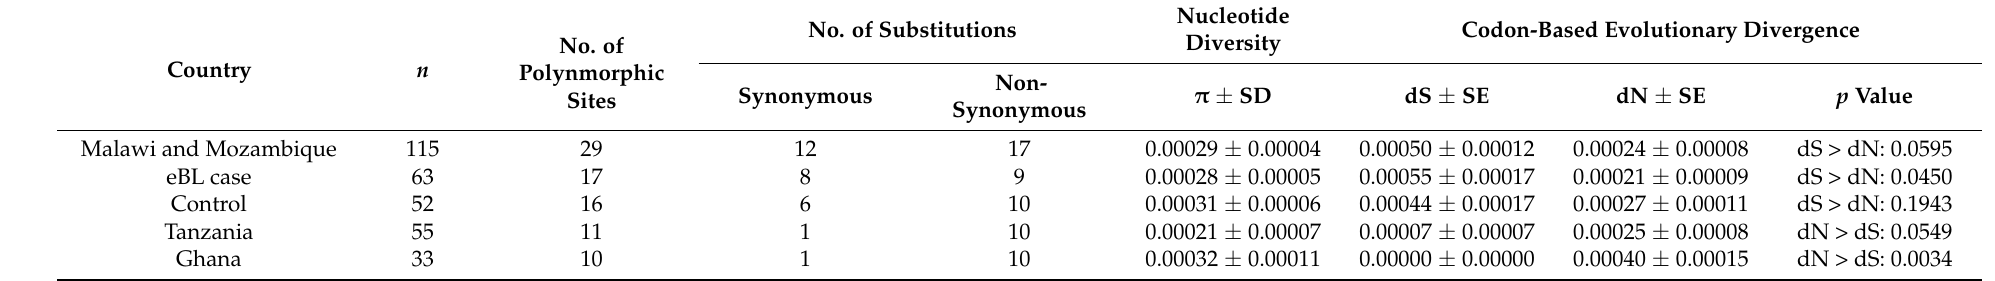
Table 3. Nucleotide divergence and polymorphism in the non-repeat 2562 bp sequence regions.